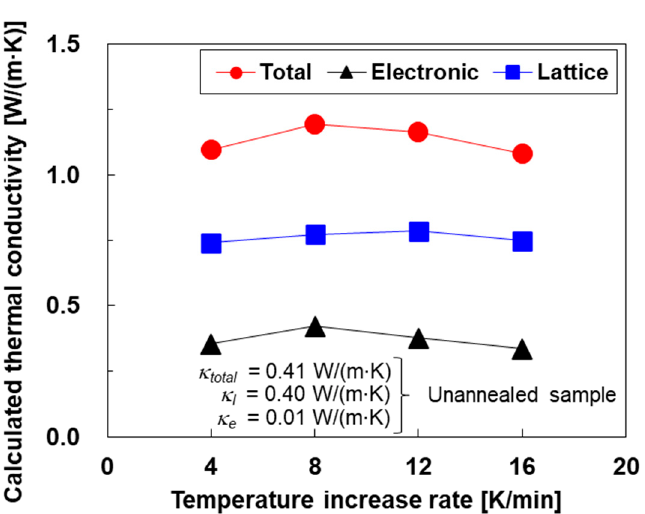
Figure 6. Calculated in-plane thermal transport properties of the prepared Bi 2 Te 3 thin